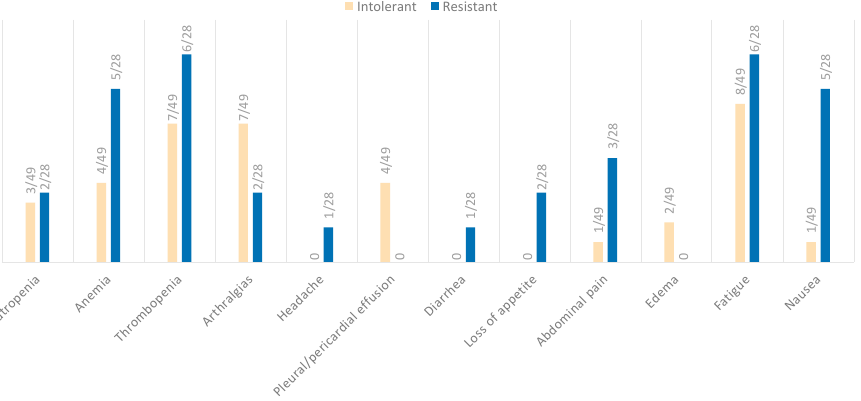
Figure 3. Frequency of adverse effects with asciminib in intolerant (pale orange) versus resistant (blue) patients.